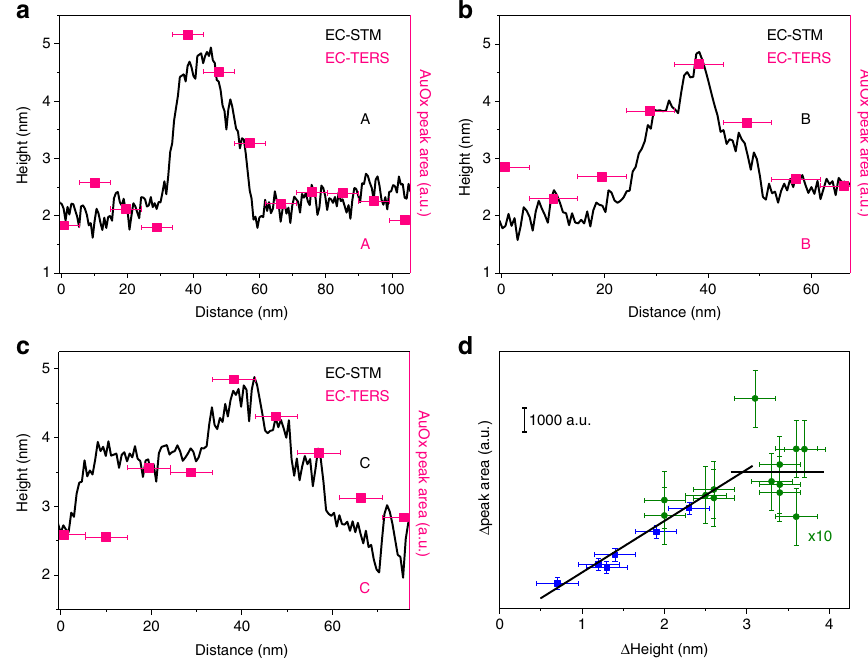
Fig. 3 Correlation between EC-STM height pro fi les and EC-TERS band intensities. a – c EC-STM (black) and corresponding EC-TERS (pink) line pro fi les from regions marked with A, B, C in Fig. 2c – f. The distance error bars (x-error) are estimated to be of the pixel size, i.e. ± 4.7 nm. d Difference in gold oxide (AuOx) peak area vs. difference in defect structure height. Blue and green data sets were recorded with different tips on different days and samples. The Δ height error bars are estimated to be ± 0.25 nm. The Δ peak area error bars are determined from the standard deviation either at fl at Au regions or in the OFF state. Solid lines are guides to the